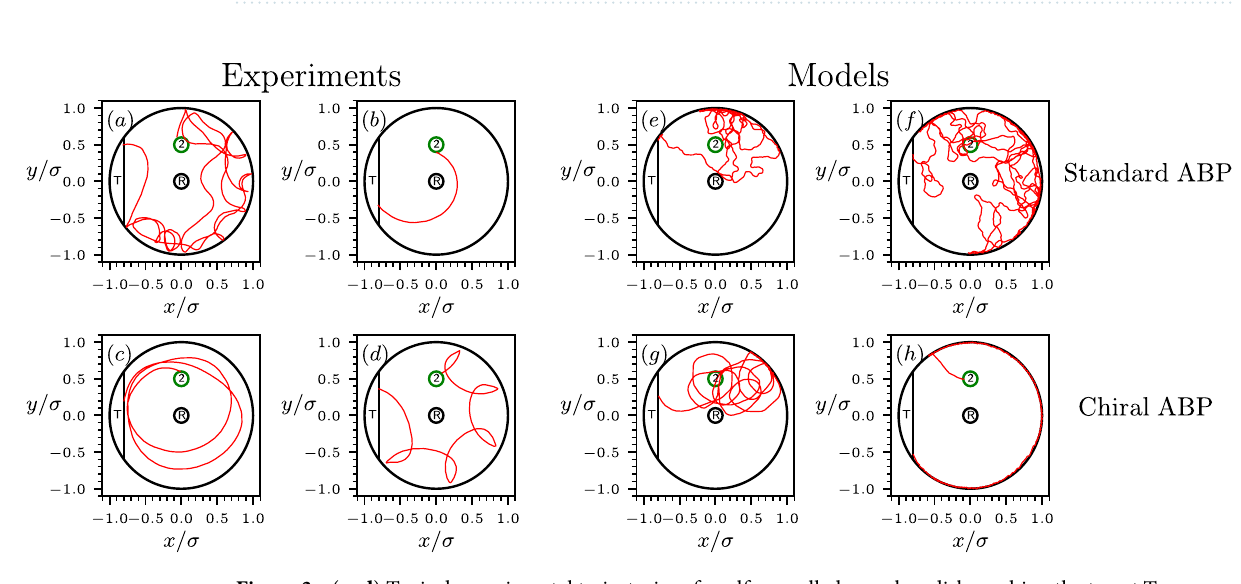
Figure 3. ( a–d ) Typical experimental trajectories of a self-propelled camphor disk reaching the target T starting from the circular region 2. ( e,f ) Typical trajectories of the standard ABP (no angular drift, ω = 0 ). ( g,h ) Examples of trajectories of the chiral